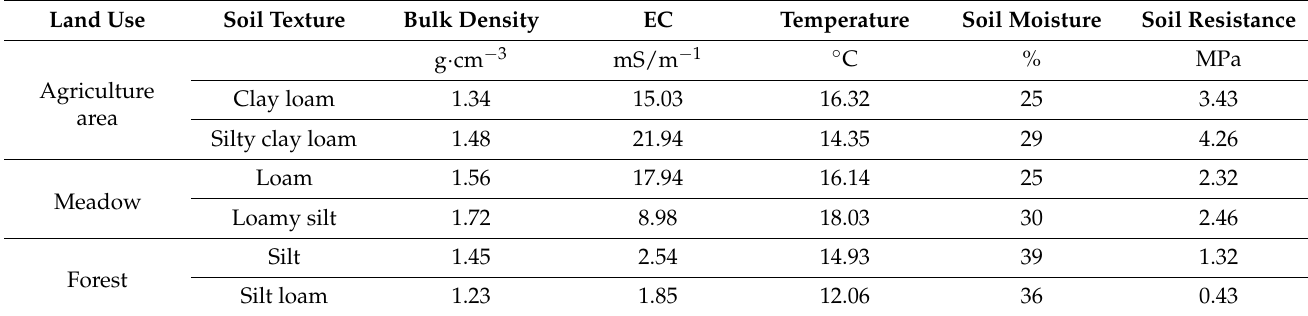
Table 2. Average values of selected parameters in the soil at the layer 0–20 cm for the Mszanka catchment. Land